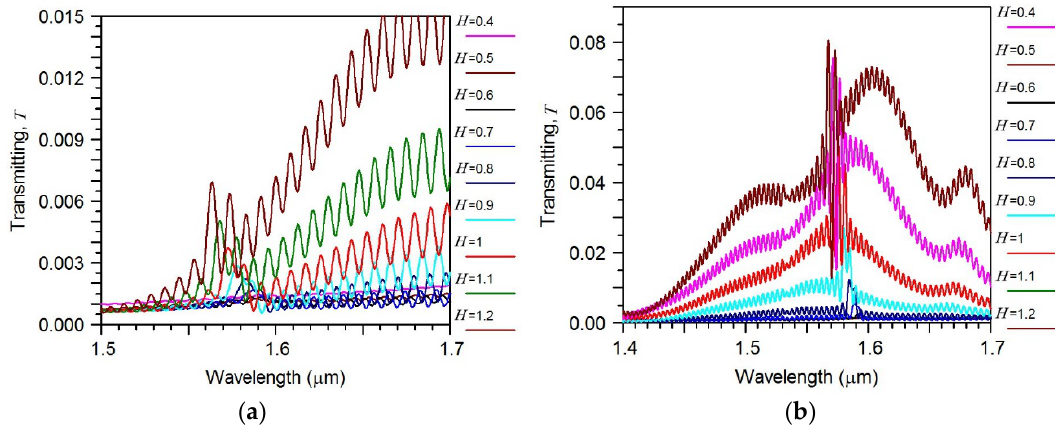
Figure 13. Transmitting power as a function of optical wavelength of the Gaussian optical beam launched into polymer strip connected with segmented grating of different height H . ( a ) M = 128; ( b ) M = 256, W = 1.0 µm, h = 0.25 µm, w = 0.45 µm, d = 0.1 µm. Simulation made by 2D FDTD.